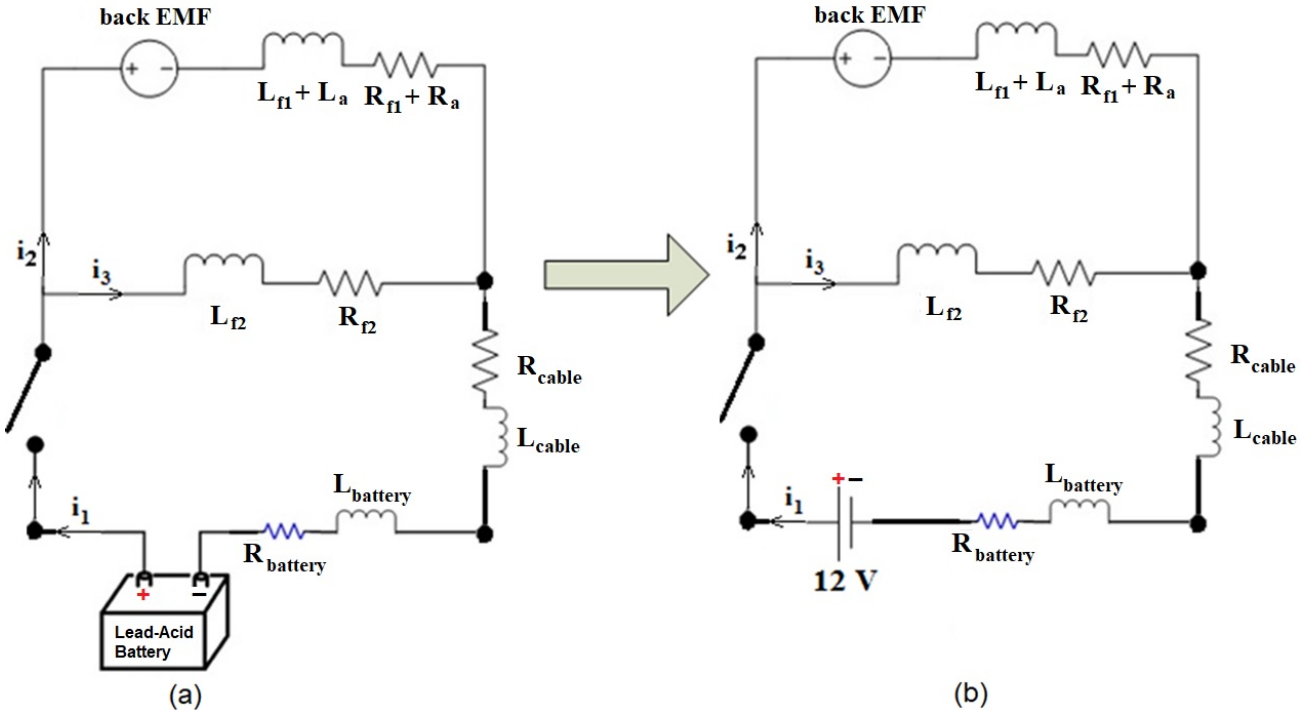
Figure 1. Engine cranking circuitry; the battery can be modeled as a constant DC power source during cranking: ( a ) symbolic circuit; ( b ) electrical circuit representation.